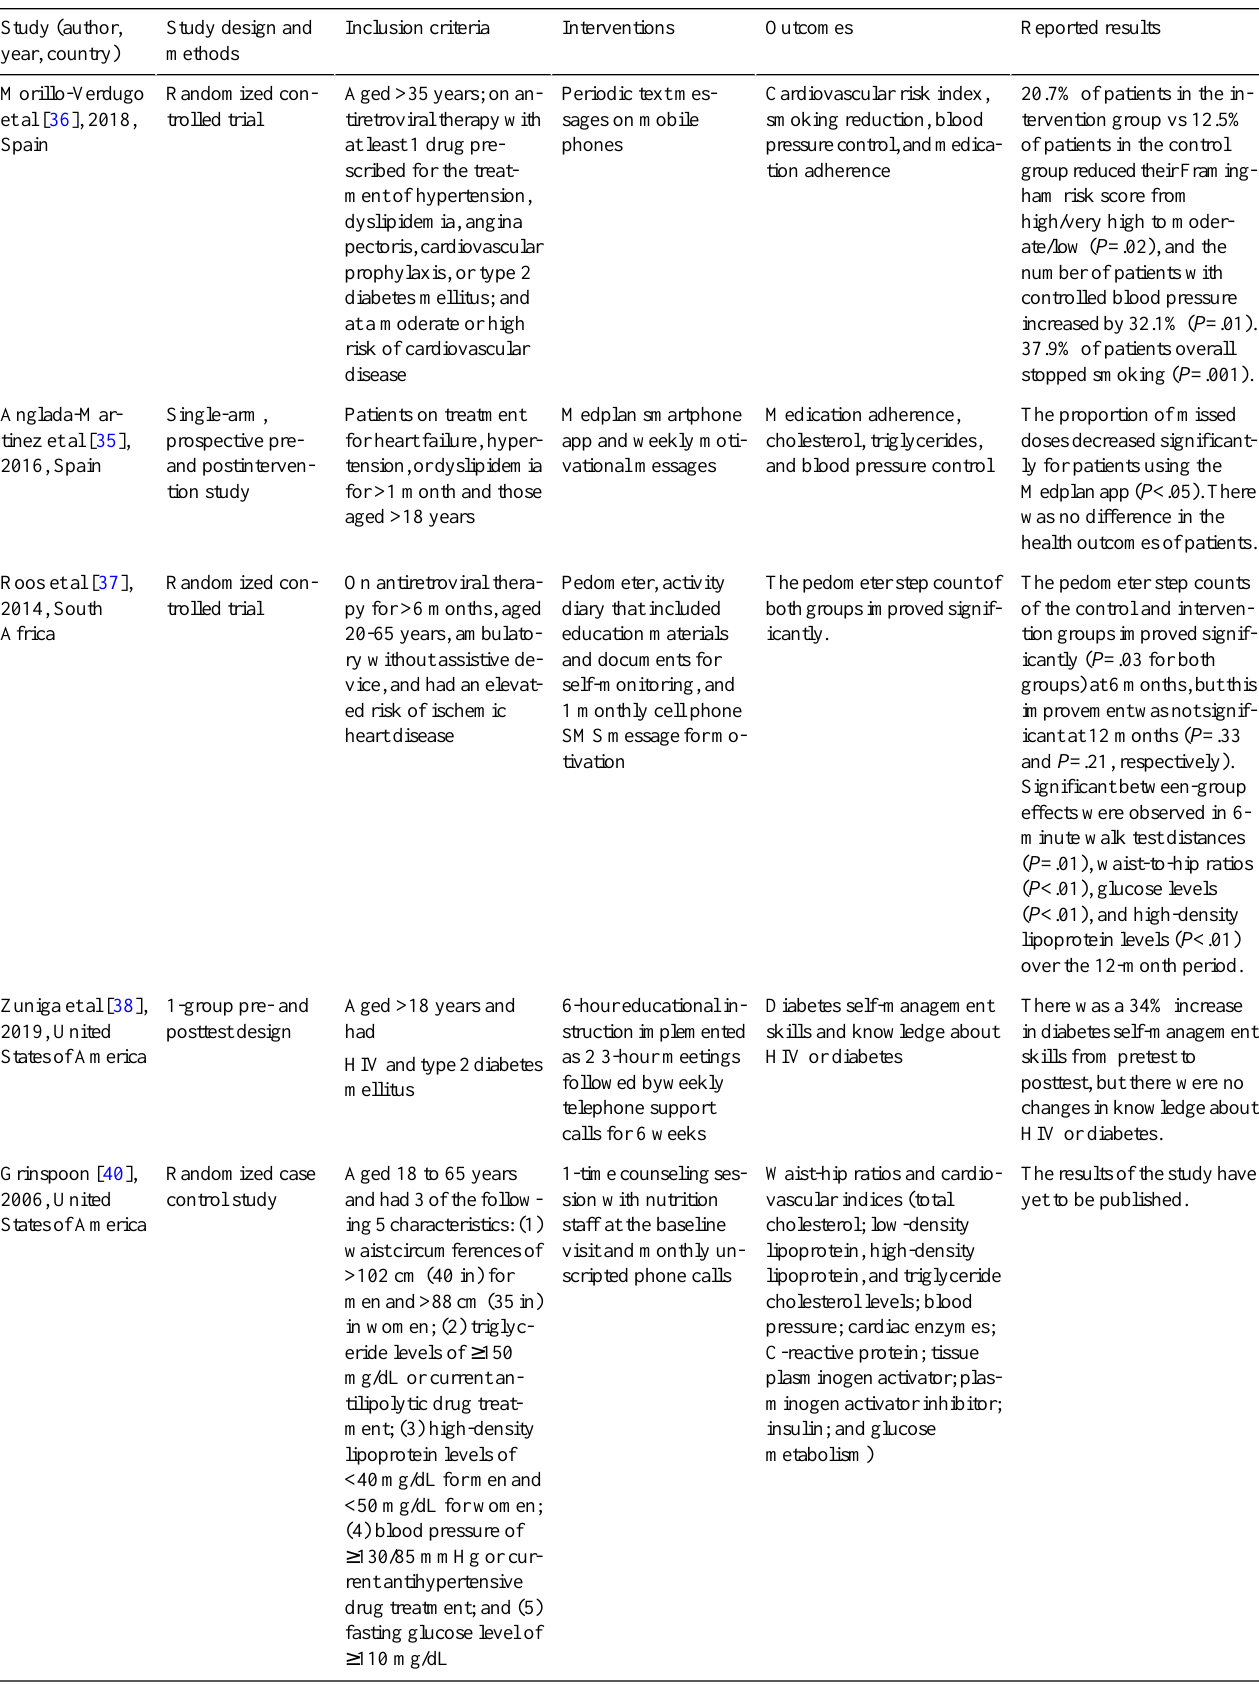
Table 1. Summary of the key characteristics of included studies